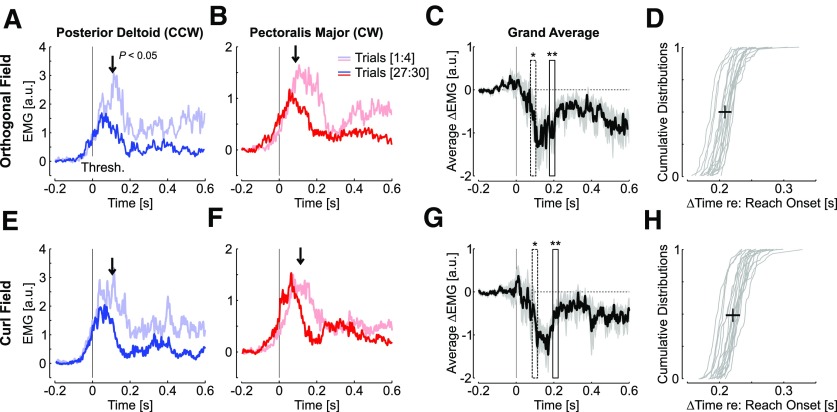

A–D, Same as Figure 2 for the orthogonal force field data from experiment 2 (a distinct group of 18 participants). Traces are first and last four trials in the force field for pectoralis major (A, blue) and posterior deltoid (B, red) aligned to the position threshold. The activity during unperturbed trials was subtracted and the traces were smoothed with a 5-ms moving average for illustration. The vertical arrows show the moment with a sliding paired comparison of activity averaged in 30-ms bins became significant (p < 0.05). C, Difference between early and late feedback responses (mean ± SEM) averaged across participants and muscles. The results of the sliding paired comparisons are shown: one star, first 30 ms-bin with p < 0.05, two stars: minimum of p (p < 0.005; see Materials and Methods). D, Individual distributions of time elapsed between reach onset and the center of the first bin with p < 0.05. The cross is the median ± SD across participants. E–H, Same as A–D for the curl force field.